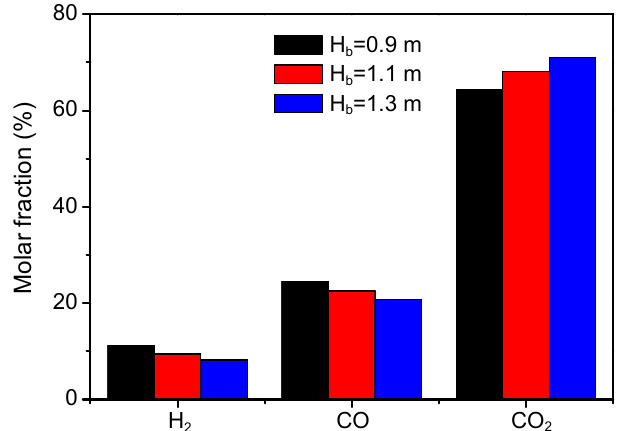
Figure 8. Distributions of N 2 -excluded flue gas concentrations (dry basis) in different solids inventories.